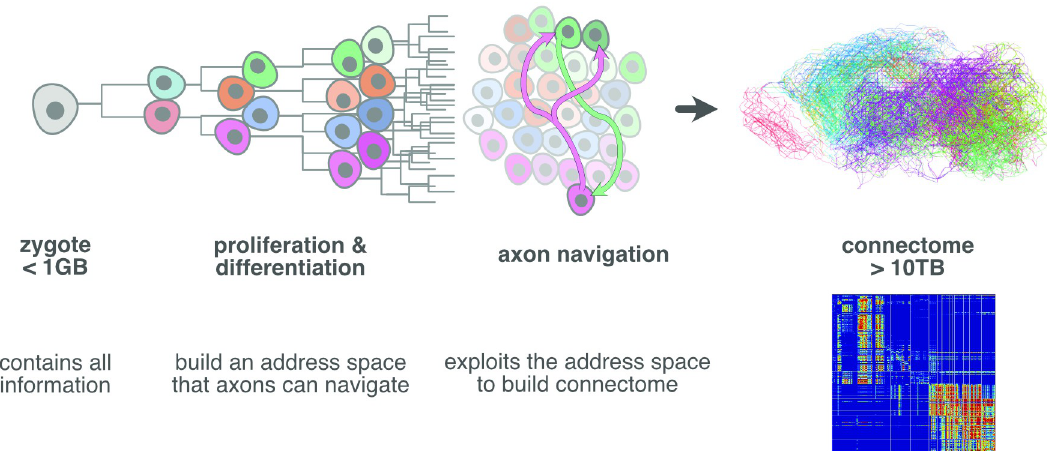
Fig 1. The connectome is the result of a constructive process that starts ultimately with the zygote, and involves the two aspects of first generating a mass of cells with various types, and then routing axons through this mass to their proper targets. An observer’s description of the resulting detailed mouse connection matrix (right bottom) takes at least 10 TB to encode. However, as development occurs largely in isolation, all instructions to construct this connectome must fit through the narrowest part of the bottleneck of inherited information: i.e., the zygotic genomic sequence. This implies that neural progenitors have efficient methods for expanding the highly compressed wiring instructions into axonal trajectories. To do this, they need to, as they proliferate and differentiate, install a space of molecular addresses that axons can exploit for